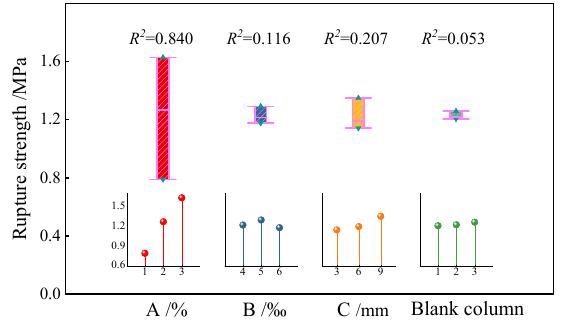
Figure 11. Influence of various influencing factors on the average flexural strength.